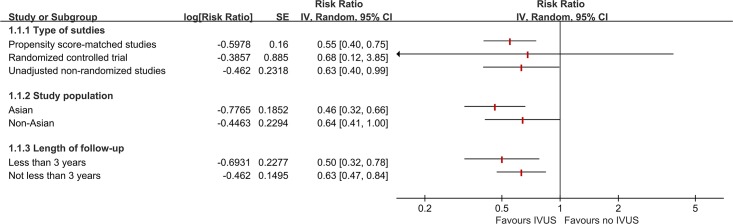
Results of subgroup analyses.